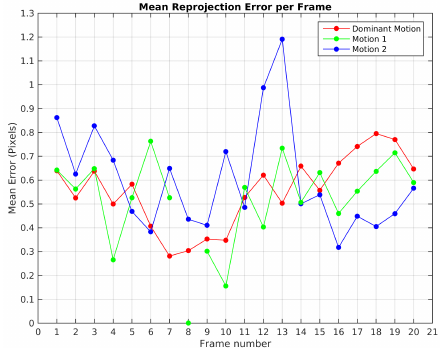
Figure 14. Mean reprojection error for Scene 4 with baseline method.